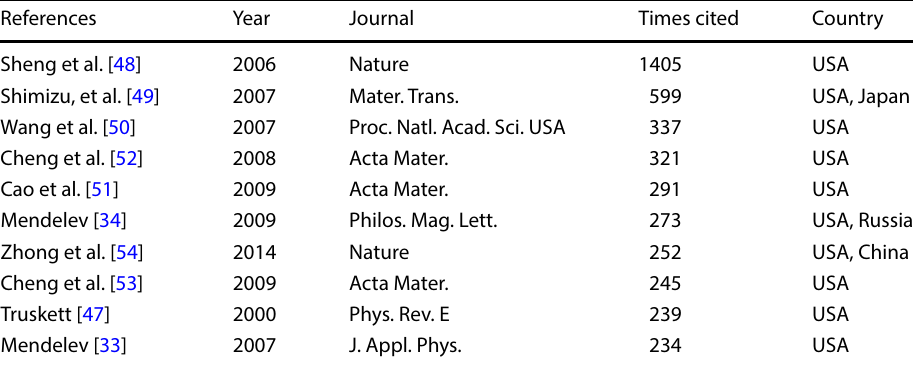
Table 1 Articles with most cites from 2000 to